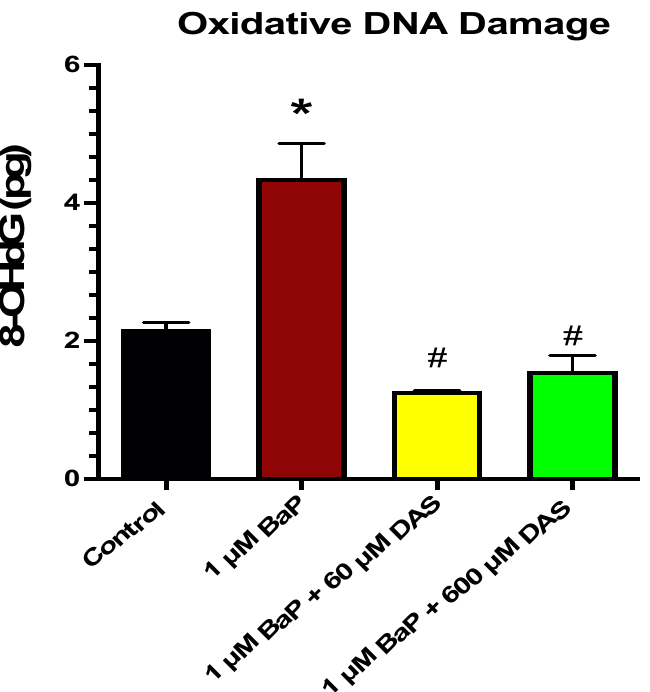
Figure 6. DAS and/or BaP effect on oxidative DNA damage in Normal Breast Epithelial Cells (MCF- 10A) determined by 8-OHdG DNA damage quantification. 8-OHdG is an indicator of oxidative DNA damage. MCF-10A cells were exposed to 1 μ M BaP and/or (60 and 600 μ M) DAS CoTx for 24 h. The results represent pg of 8-OHdG as an indicator of oxidative DNA damage. The data points are presented as the mean ± SEM of three replicates. The significance of the difference was analyzed using an unpaired t -test to compare 8-OHdG expression vs. control (* p < 0.05) or vs. treated cells ( # p < 0.05).